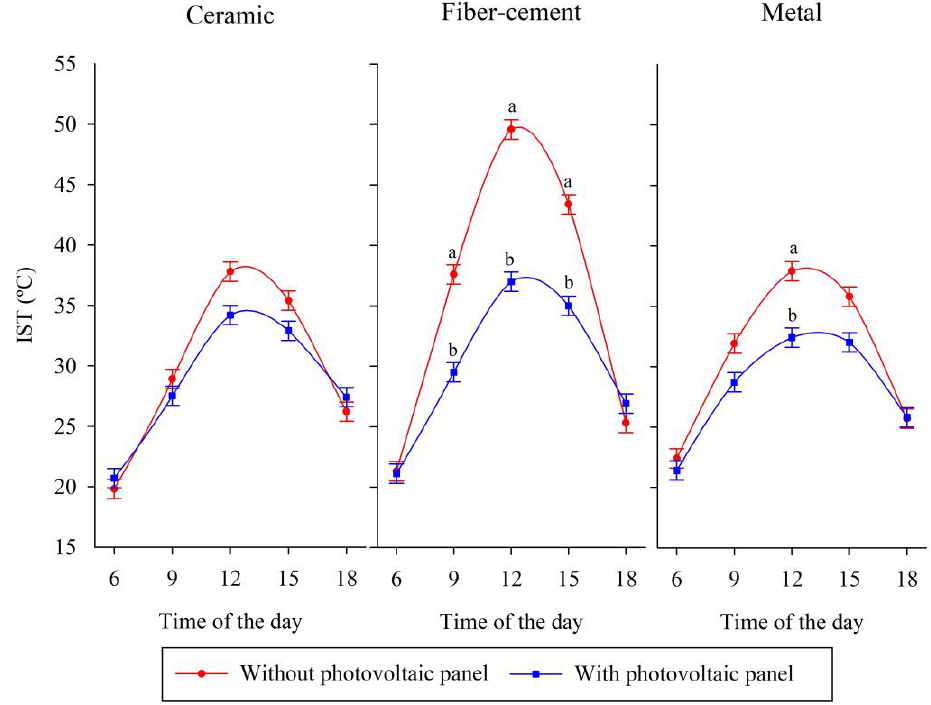
Figure 3. Behavior of the internal surface temperature (IST) values of the tiles and the unfolding of the interaction between the absence and presence of the photovoltaic panel for the three types of tiles analyzed within the hours. Different letters indicate that the values are statistically different, and the absence of the letter indicates that there were no significant differences.